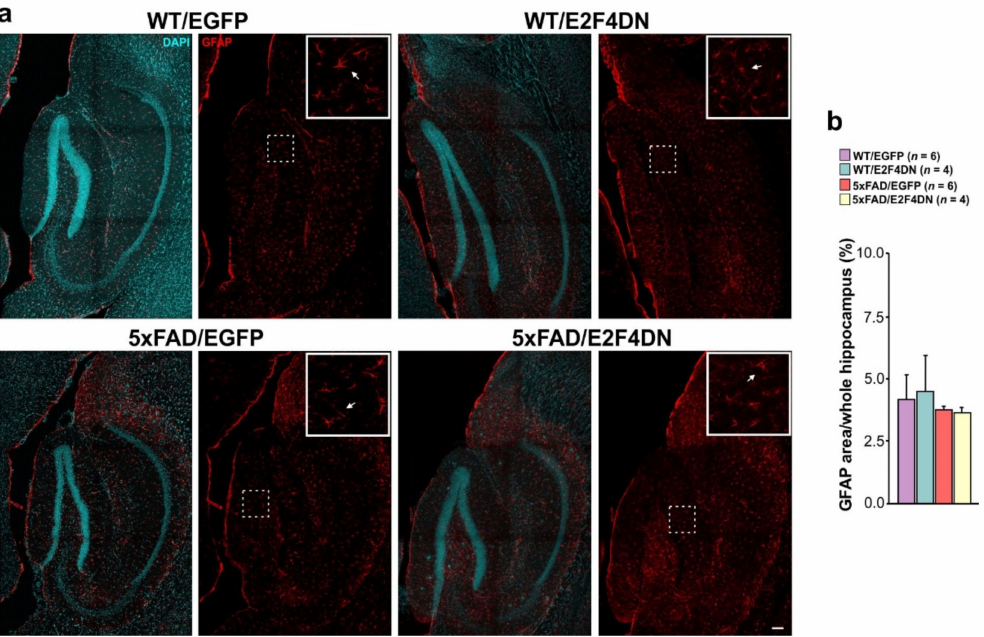
Figure 6. Modulation of astrogliosis by E2F4DN in the hippocampus of 1-year-old 5xFAD mice. ( a ) GFAP immunostaining (arrow) in the hippocampus of mice with the indicated genotypes. Inserts show the high magnifications of the indicated dashed boxes. DAPI counterstaining was included to identify the hippocampus. ( b ) Percentage of the area occupied by GFAP immunostaining in the hippocampus. Scale bar: 100 µ